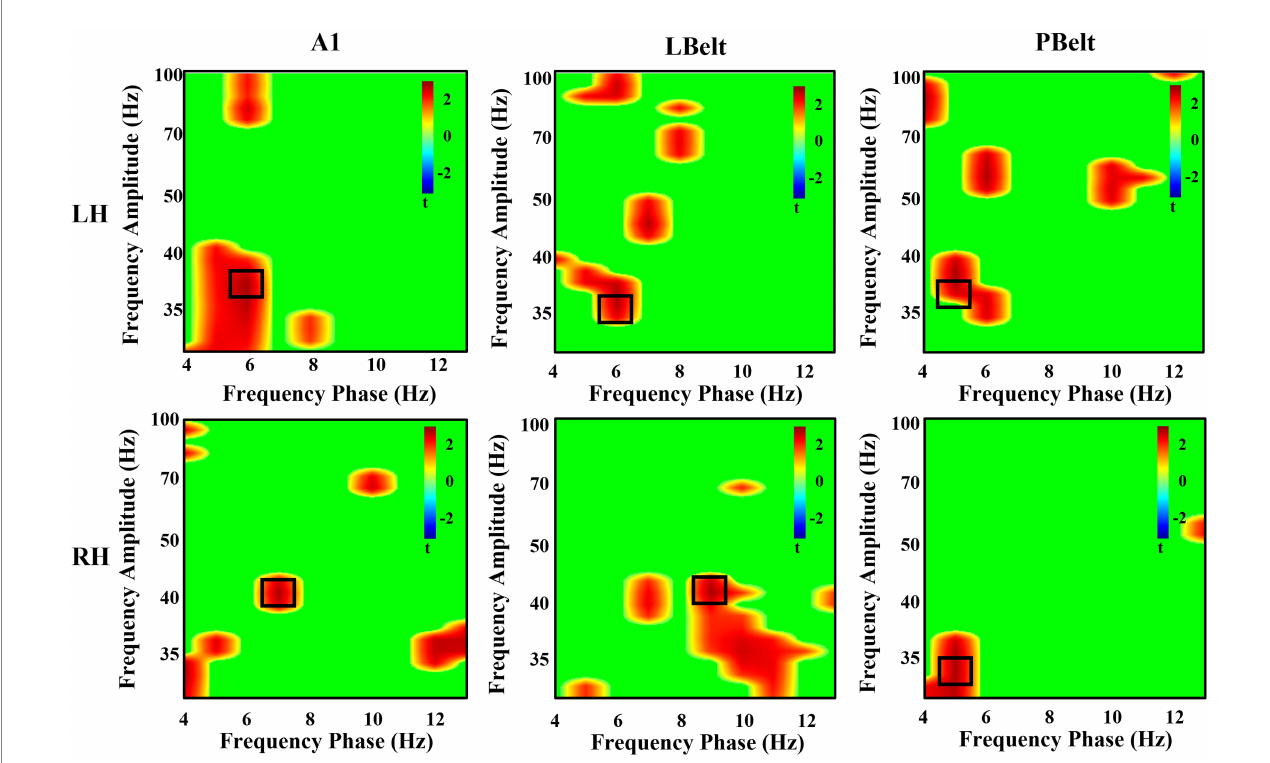
FIGURE 3 Exploratory uncorrected phase-amplitude coupling analysis in auditory cortex. There were uncorrected significant increases in coupling between low- frequency phase and gamma power. All, except right LBelt, areas showed the greatest coupling increase with attention between theta phase and gamma power. Right LBelt showed the greatest coupling increase with attention between alpha phase and gamma power. Peak coupling within each area is outlined in